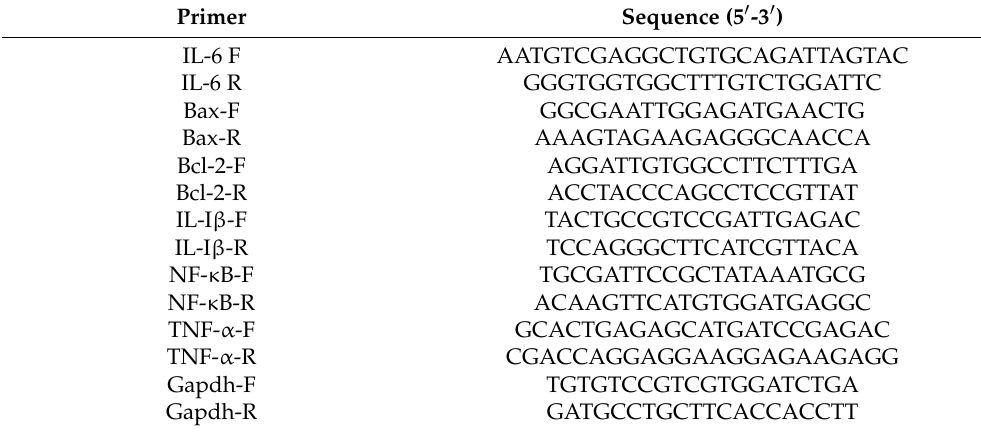
Table 2. Primers used in the present